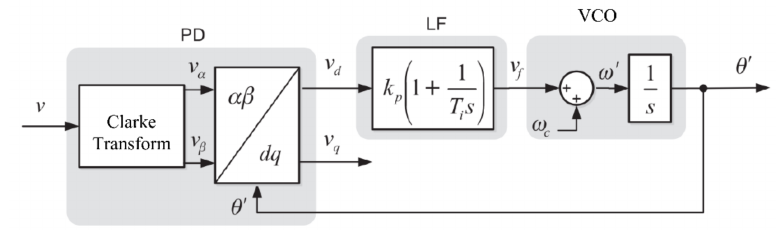
Figure 4. The structure diagram of